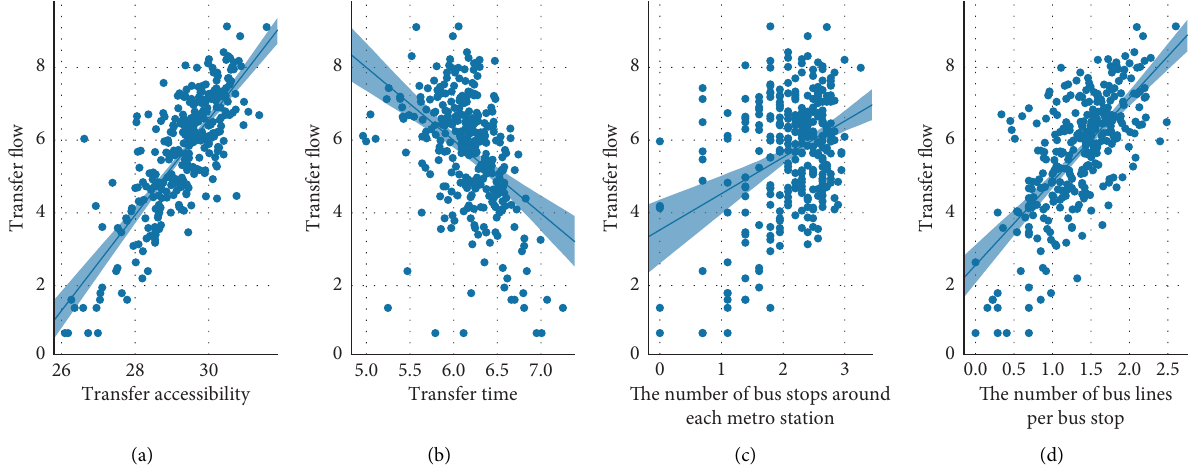
Figure 12: The relation between four attributes and transfer flow: (a) transfer accessibility, (b) transfer time, (c) the number of bus stops around each metro station, and (d) the number of bus lines per bus stop.